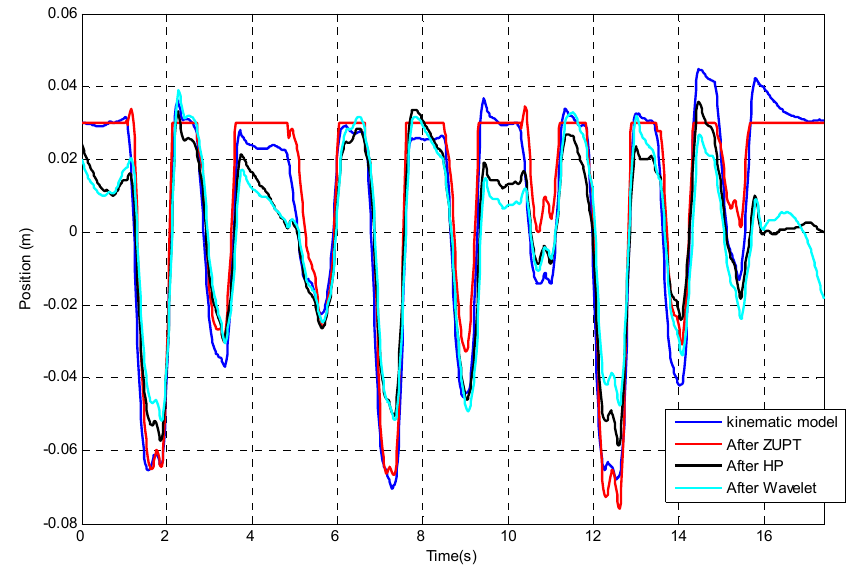
Figure 17. Comparison between the drift correction methods. Table 1. Coefficient comparison between the drift removal methods.